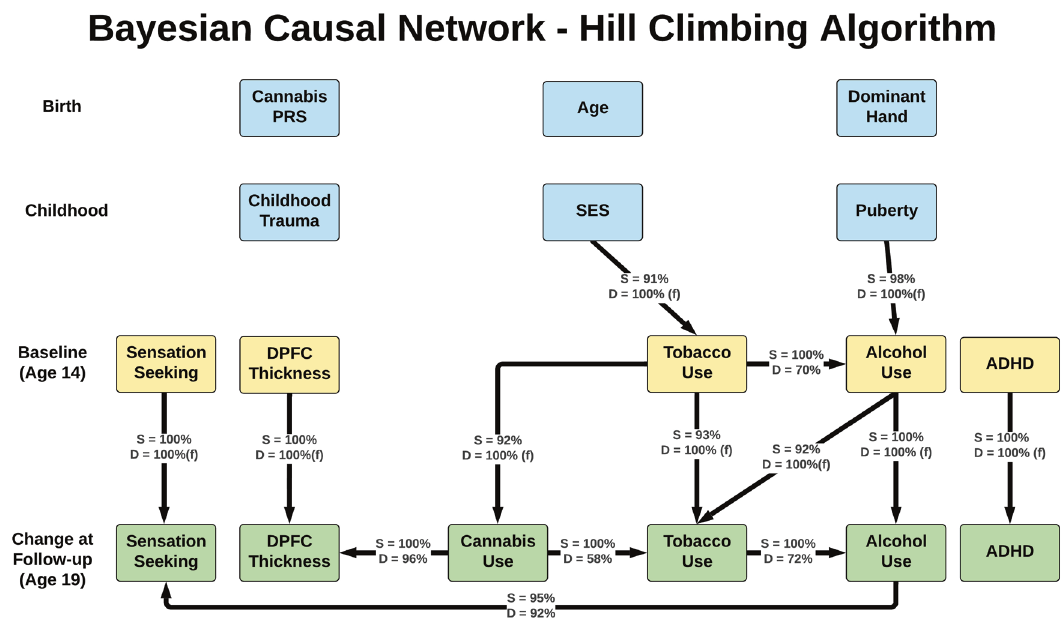
Fig. 1 Primary Analysis: Bayesian network model from the hill climbing algorithm. Boxes represent variables used in Bayesian Causal Network models. Yellow boxes are age 14 variables, green boxes are change from age 14 to 19 variables, and blue boxes are other variables of interest. Lines indicate a dependent relationship between two variables in at least 90% of 10,000 bootstrapped models (i.e., strength ≥ 90%). Arrows indicate directional of relationship found between two variables. S = strength, representing the percentage of bootstrapped models in which a dependent relationship was present. D = direction, representing the percentage of bootstrapped models with a dependent relationship in which a connection was in the direction shown in the fi gure. (f) = connection with direction pre-speci fi ed to fi t with temporal ordering. Note: all participants were cannabis-naïve at age 14. All variables were residualized for site and